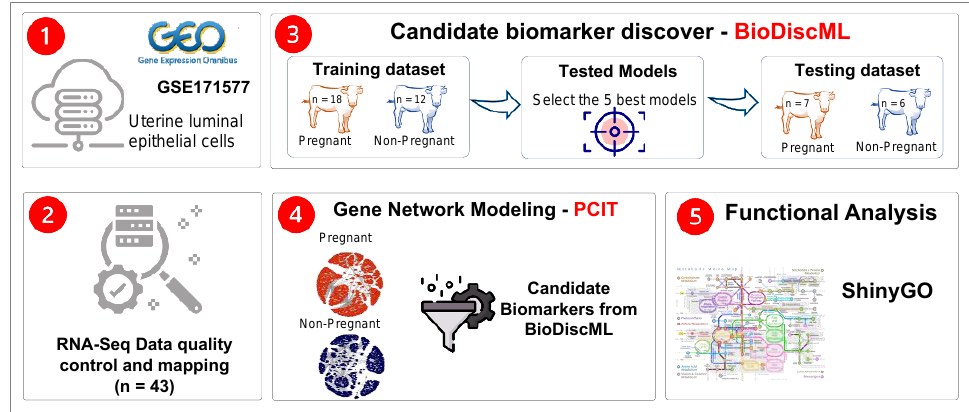
Figure 1. Overview and analysis workflow to identify predictive biomarkers of pregnancy status and fertility-related networks in cows.